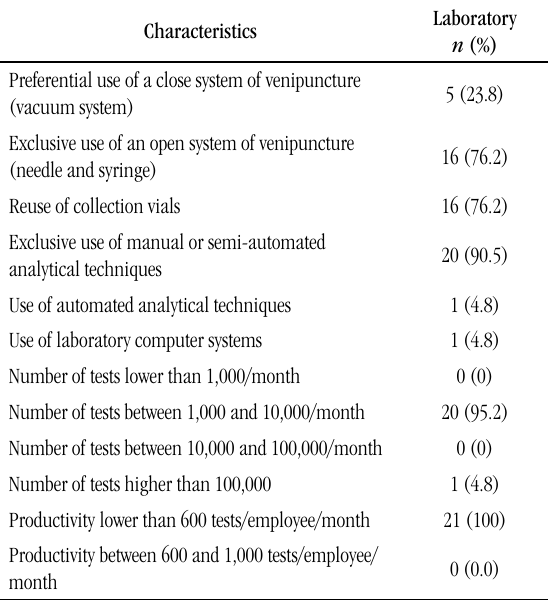
tABLE 1 – Profile and productivity of the 21 studied laboratories